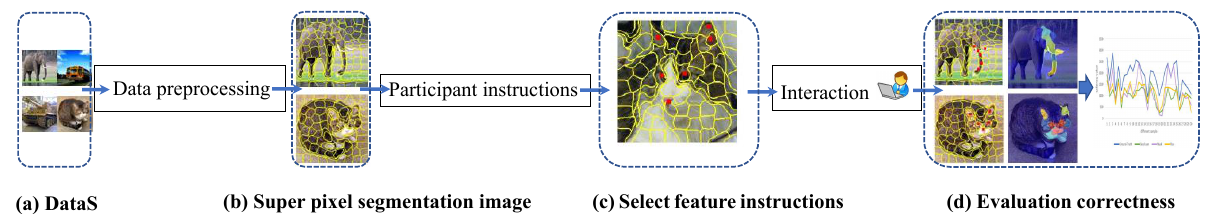
Figure 4. Accuracy Evaluation (AE) pipeline of interpretation methods. There are four steps in total: dataset (DataS), pixel segmentation, pixel feature selection and evaluation process.